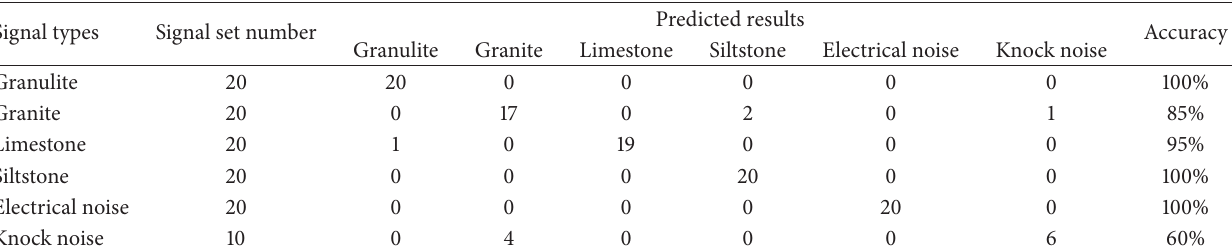
Table 5: Signal type prediction using the